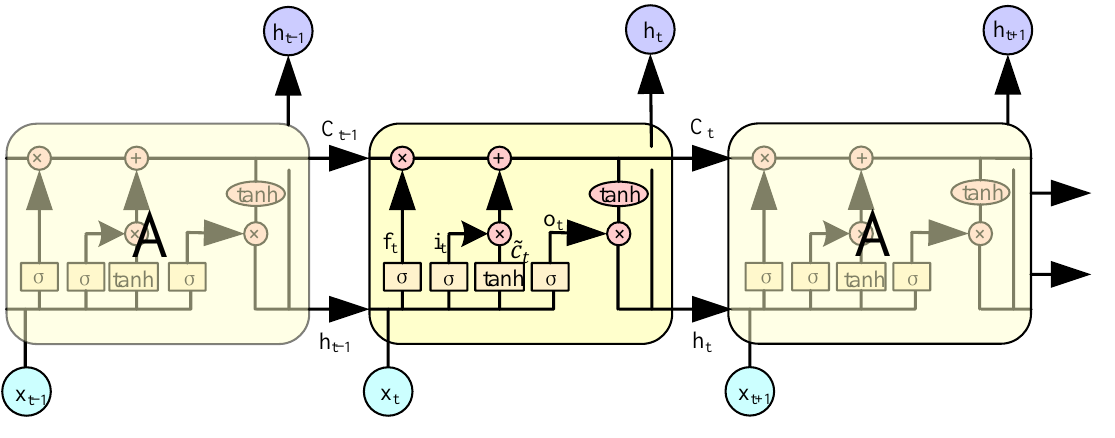
x t Figure 2. RNN network structure unfolded along the time line.